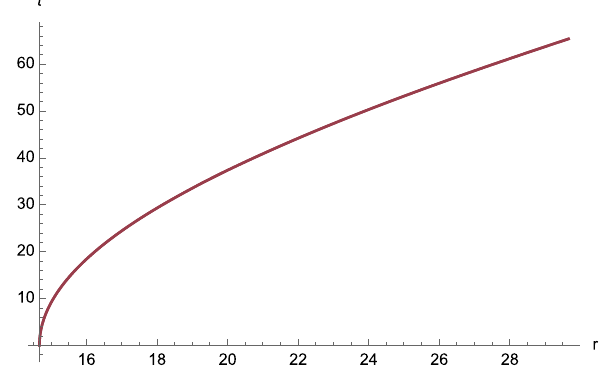
Fig. 14 The function τ = τ( r ) for first-kind orbits having C 2 E 2 < 1. The following constants have been chosen: τ 0 = 0, M = 2, e = 4 . 5, (cid:10) = 11, ε = ± 1, and C = 1